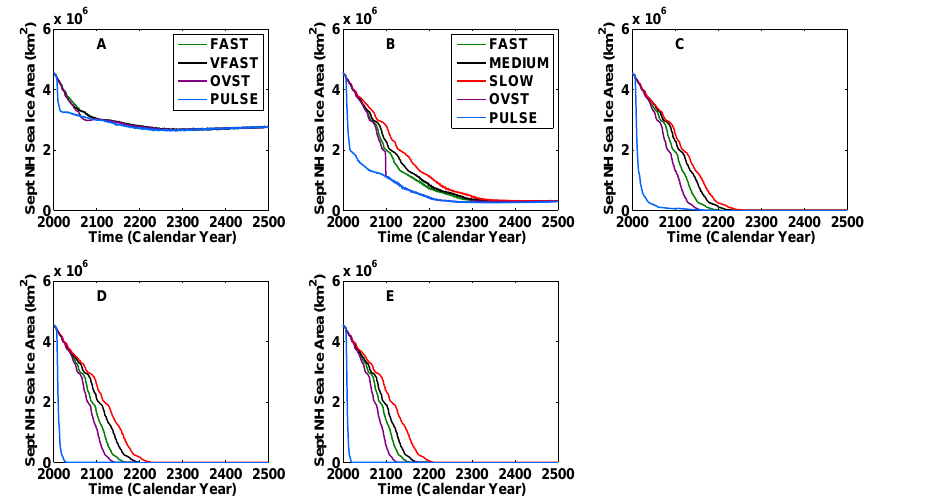
Figure 6. September Northern Hemisphere (NH) sea ice area (km 2 ) for the 1275–5275GtC scenarios. (a) 1275GtC scenarios, (b) 2275GtC scenarios, (c) 3275GtC scenarios, (d) 4275GtC scenarios, and (e) 5275GtC scenarios. Note: legend for (b) also applies to (c–e) .